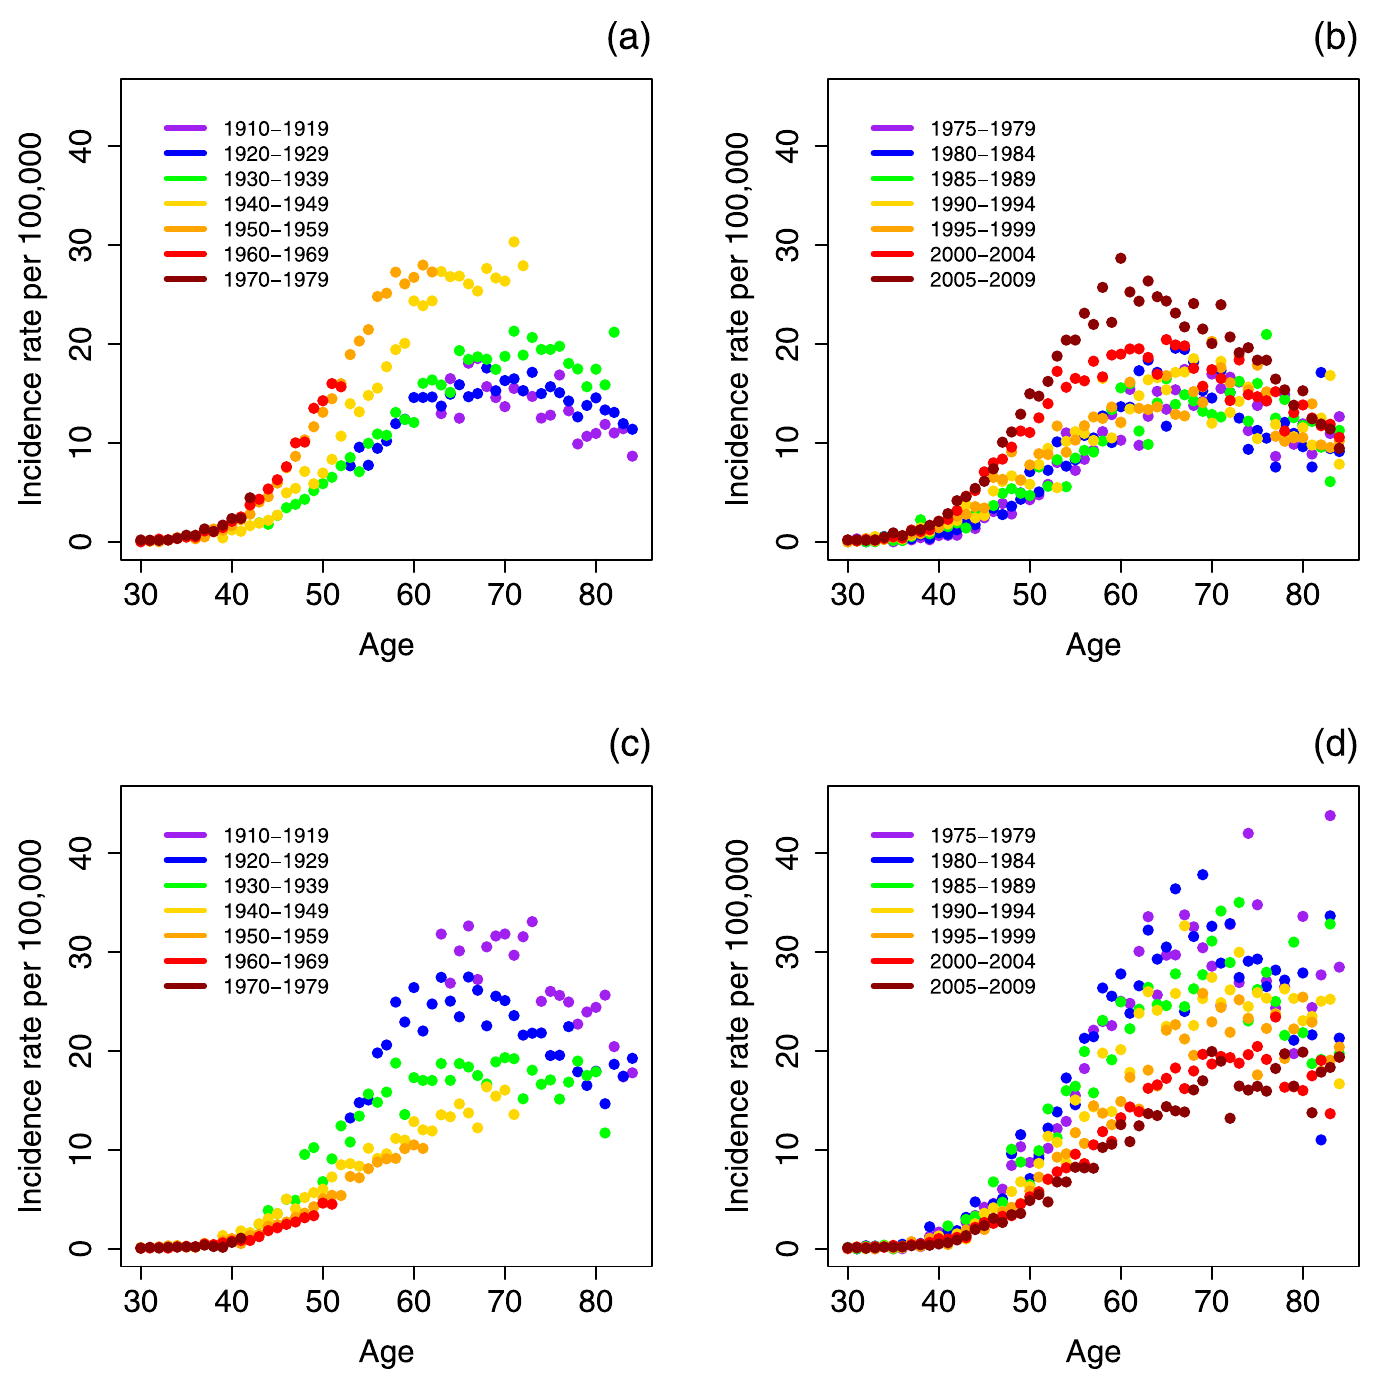
Fig 3. Incidence rates of oral squamous cell carcinoma among white males for HPV-related, by cohort (a) and period (b), and HPV-unrelated subsite groups, by cohort (c) and period (d).